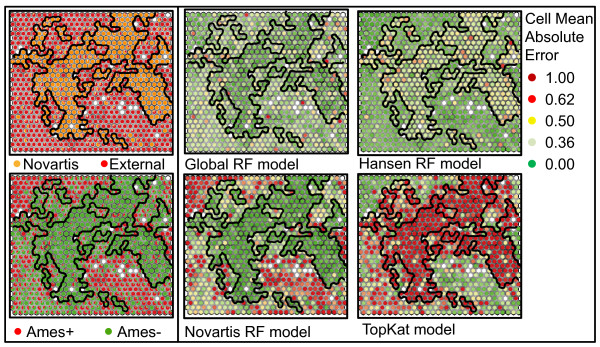
Performance of global models mapped to chemical space. Self-organizing map of Sets C, D, E, and F (from Figure 4) again colored by whether the molecule is in the Novartis set (Set C, orange) or is Ames+ (red) in the left box. In the right box, the SOM is colored by the mean absolute error of the predictions in the cell for the indicated model. Dark green indicates correct classification, yellow an equivocal prediction, and red an incorrect prediction. Cell mean absolute error is defined as the difference between the predicted probability of being mutagenic and the experimental class (0 or 1).